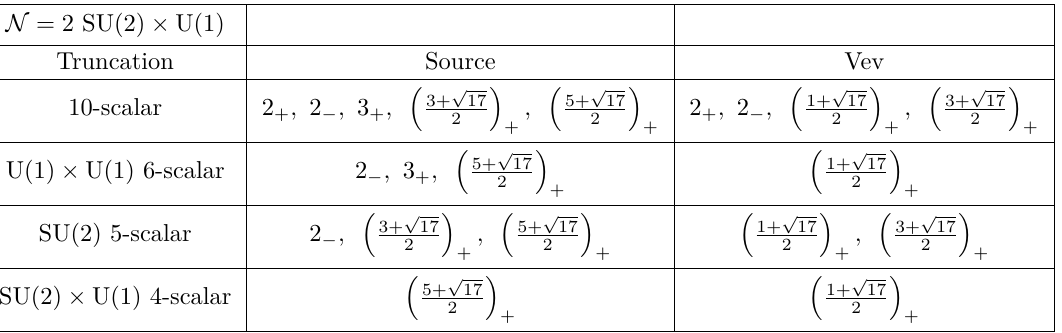
Table 2 . BPS modes and multiplicities for the N = 2 SU(2) × U(1) invariant S-fold. N = 4 SO(3) × SO(3)